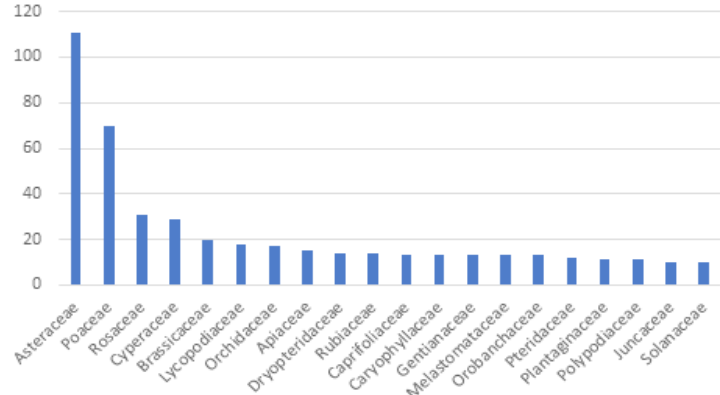
Figure 3. Number of species per family (≥ 10